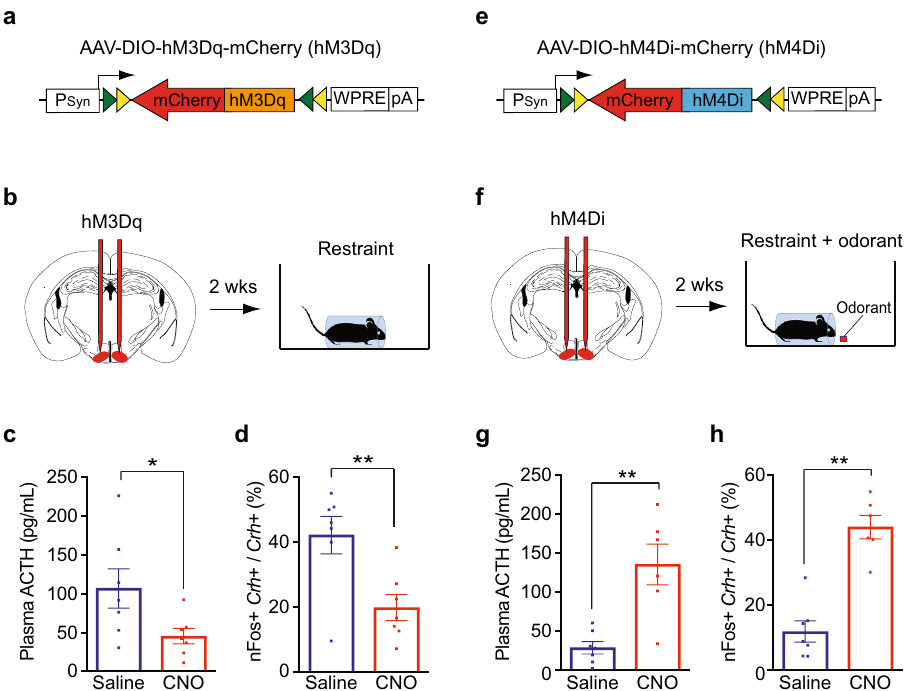
Figure 4. Silencing VMH GABAergic neurons affects odor blocking of stress. ( a,b,e,f ) AAVs with Cre- dependent expression of hM3Dq or hM4Di were used to activate (hM3Dq) ( a ) or silence (hM4Di) ( e ) VMH GABAergic neurons in Gad2-Cre mice. After ~ 2 weeks, animals were injected with CNO to activate hM3Dq or hM4Di, or with control saline, and then exposed to physical restraint (hM3Dq) ( b ) or physical restraint plus 2PE (hM4Di) ( f ). Plasma ACTH was then measured, and brain sections were costained for CRH and nFos. ( c,d ) Activation of VMH Gad2+ neurons with hM3Dq inhibits restraint-induced increases in ACTH and CRHN activation. Following restraint, CNO-treated animals showed significant decreases in plasma ACTH ( c ) and the percentage of Crh+ CRHNs stained for nFos ( d ) compared to animals treated with saline. Column heights indicate means, error bars indicate S.E.M., and dots in the same column indicate different animals. n = 7 per condition. Unpaired t test, *P < 0.05, **P < 0.01. ( g,h ) Silencing of VMH Gad2+ neurons with hM4Di interferes with the ability of 2PE to block restraint-induced increases in plasma ACTH and CRHN activation. In animals exposed to restraint plus 2PE, CNO treatment resulted in significant increases in plasma ACTH ( g ) and the percentage of CRHNs stained for c-Fos ( h ) compared to saline treatment. Column heights indicate means, error bars indicate S.E.M., and dots in the same column indicate different animals. n = 6–7 per condition. Unpaired t test, **P <